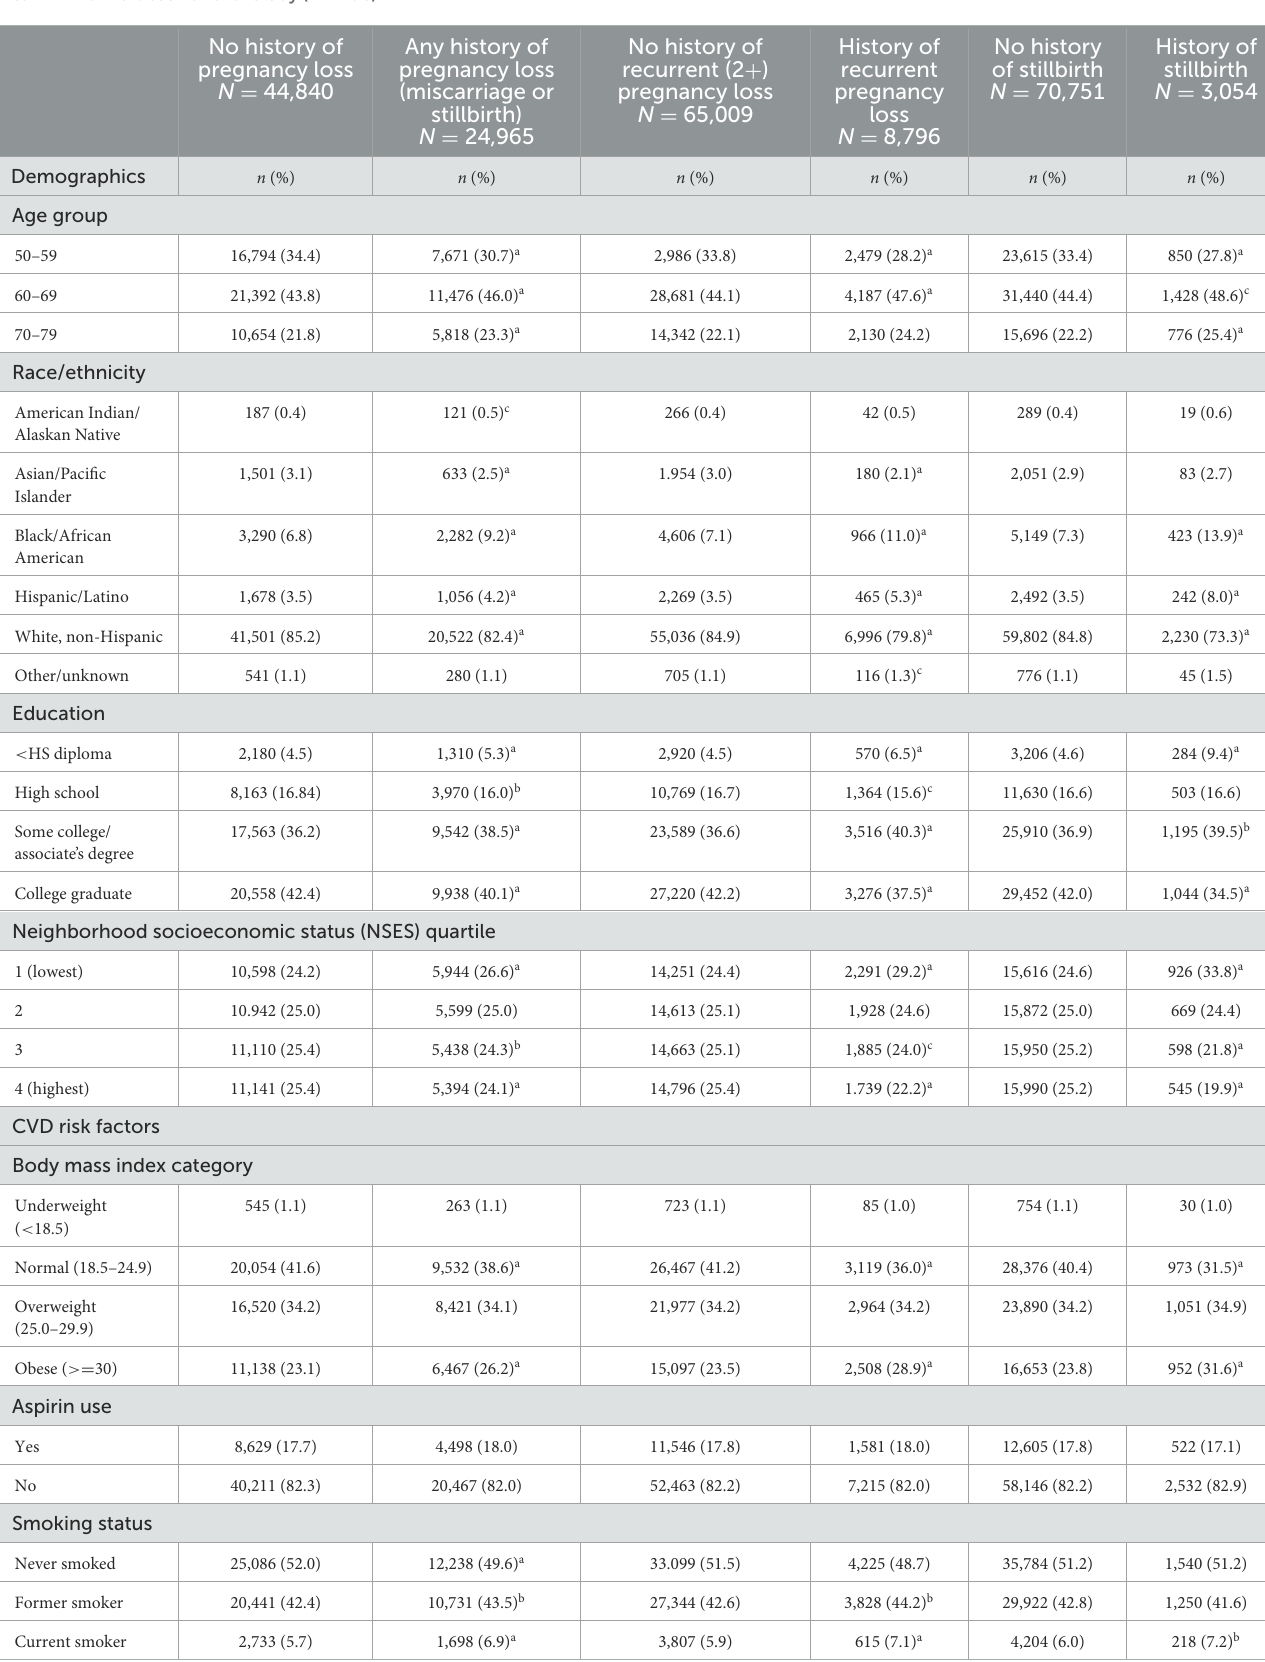
TABLE 1 Baseline demographic characteristics, cardiovascular disease risk factors, and reproductive history in selected participants from the Women’s Health Initiative Observational Study (WHI